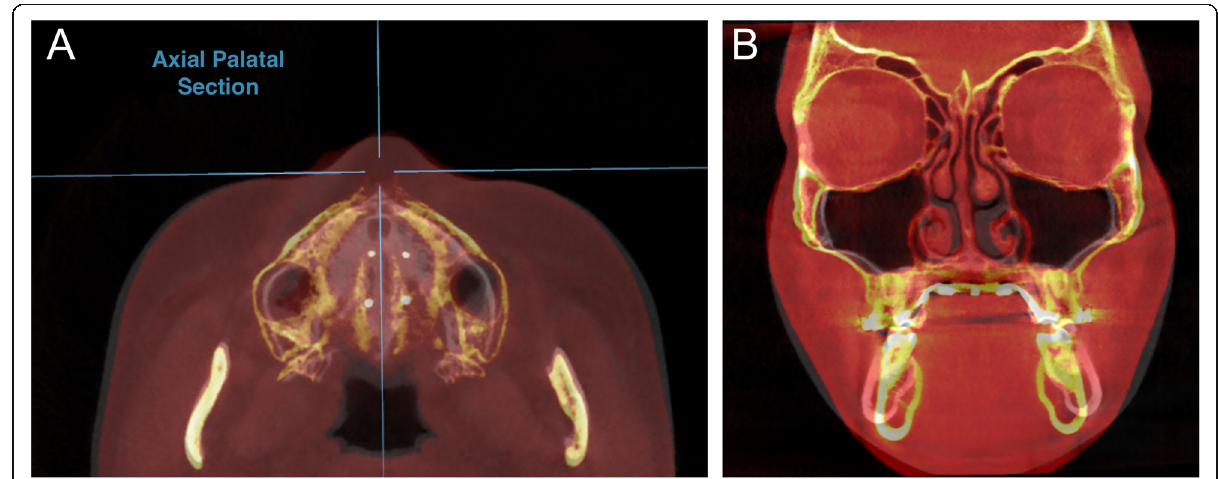
Fig. 3 a Superimposition of pre- and post-expansion CBCT images. b Superimposed image of an MSE patient in the coronal zygomatic